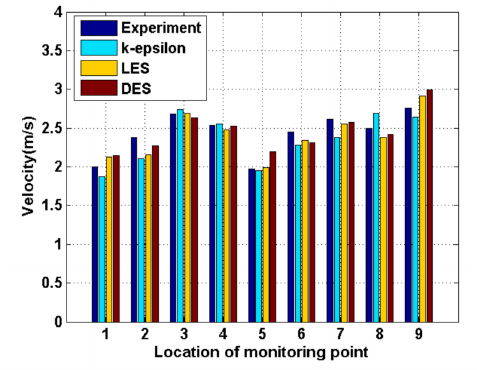
Figure 5. Simulation calculation and experimental data comparison (at 2000